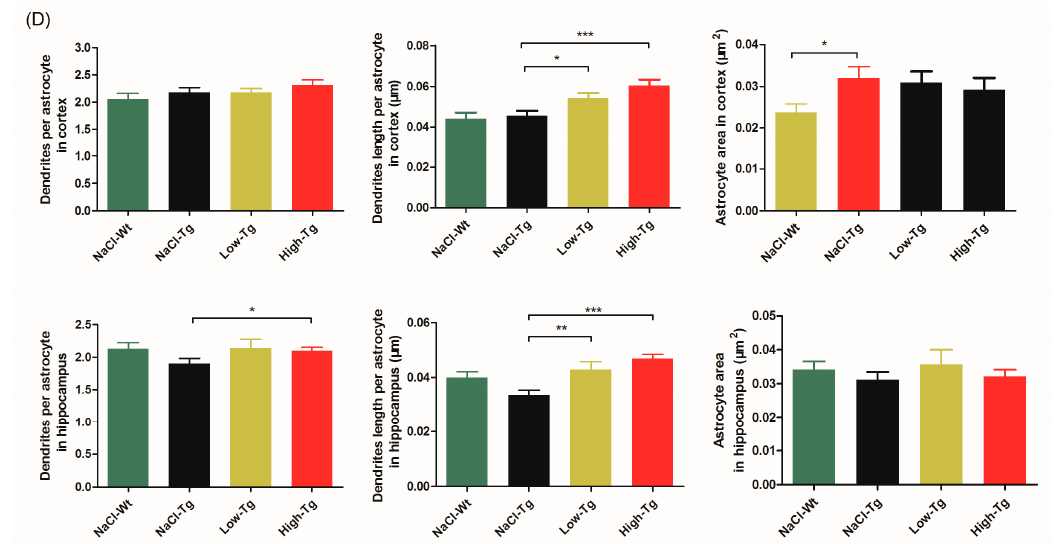
Figure 5. Immunohistochemical (IHC) analysis of astrocytes and microglia in the cortical and hippocampal section of APPswe/PSEN1dE9 mice treated with DhHP-6. ( A , B ) Representative IHC photomicrographs of astrocytes (GFAP+) and microglia (Iba-1+) in the cerebral cortex and hippocampus of APPswe/PSEN1dE9 mice, scale bar = 100 µ m (insert graph and arrows: the typical morphological characteristics of neurons). ( C ) Number of dendrites, dendritic length, and microglial area. The number of dendrites around the neurons was defined as dendrites ( # p < 0.05; ## p < 0.01; ### p < 0.001; *** p < 0.001; & p < 0.05). ( D ) Astrocyte score and morphology (* p < 0.05; ** p < 0.01; *** p < 0.001).